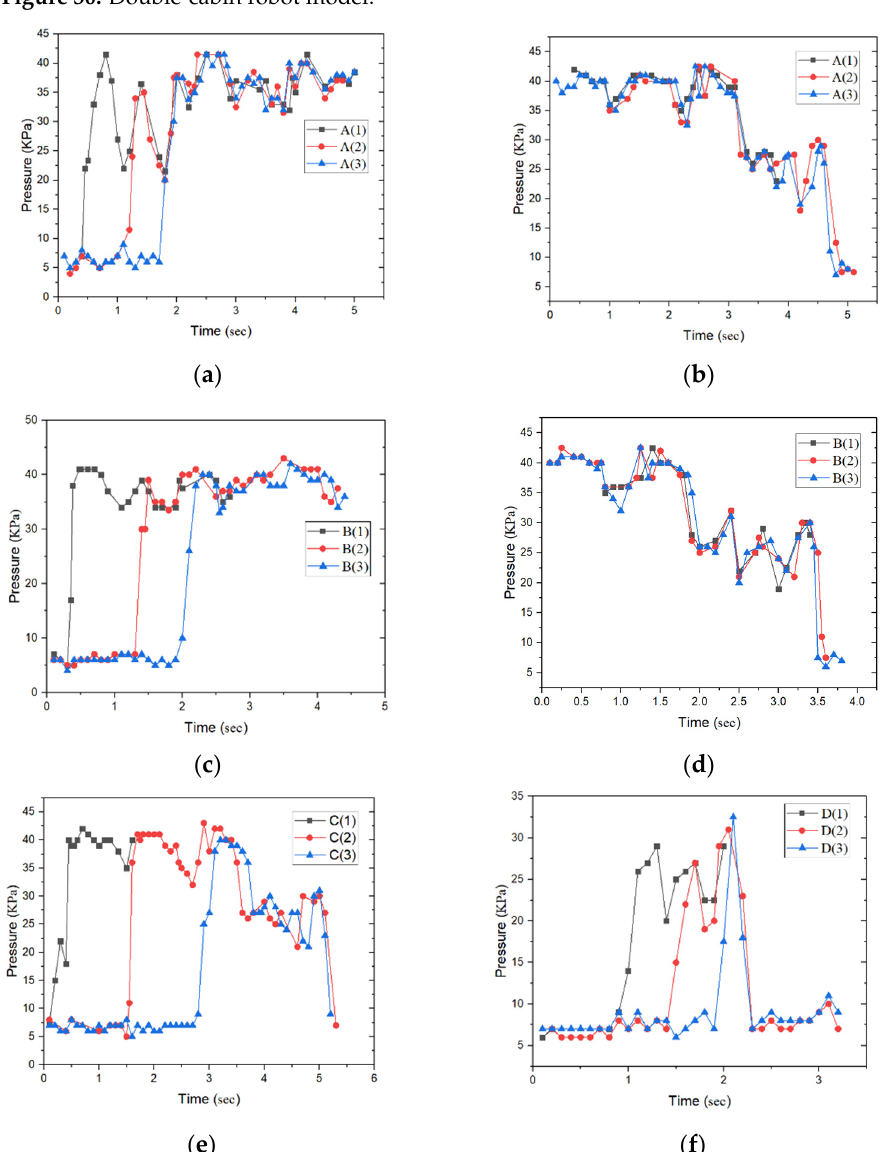
Figure 31. Pressure changes of the two-cabin robot at the different monitoring points (A, B, C and D): ( a ) Front section robot A point pressure curve; ( b ) Back section robot A point pressure curve; ( c ) Front section robot B point pressure curve; ( d ) Back section robot B point pressure curve; ( d ) Front section robot B point pressure curve; ( e ) Point C pressure curve; ( f ) Point D pressure curve.